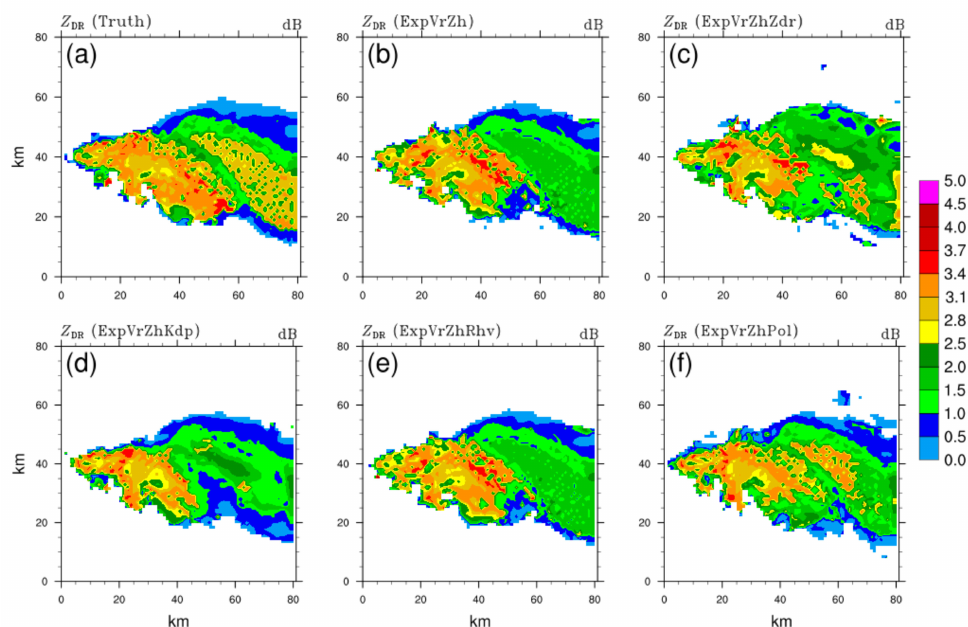
Figure 4. The same as Figure 3, but for the differential reflectivity Z DR (unit: dB) of ( a ) truth, and analysis fields of ( b ) ExpVrZh, ( c ) ExpVrZhZdr, ( d ) ExpVrZhKdp, ( e ) ExpVrZhRhv, and ( f ) ExpVrZhPol, respectively.